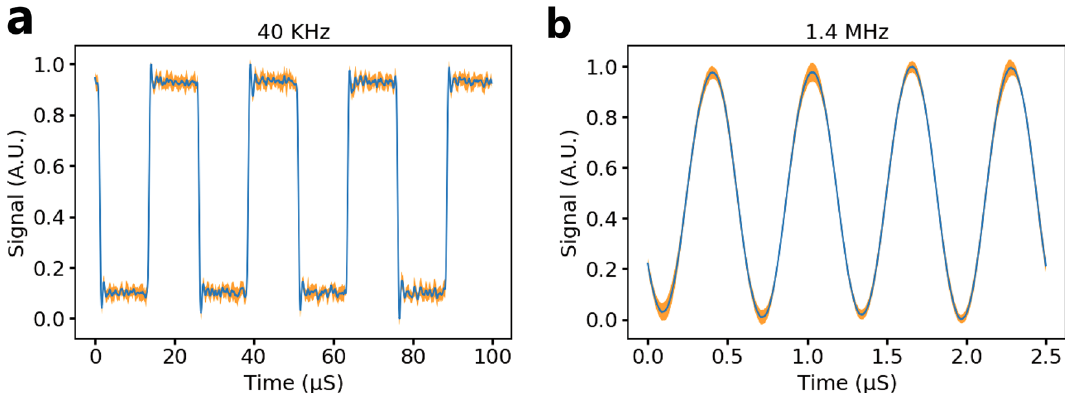
Figure 4. Time domain signals measured at 40 kHz ( a ) and 1.4 MHz ( b ). Both signals were measured at a range of 150 mm with a 20 mm aperture. The blue trace represents the average response to a 45 mV square wave input, calculated with 20 frames. The orange shaded region shows the standard deviation of the signal at that point in each frame, calculated with 20